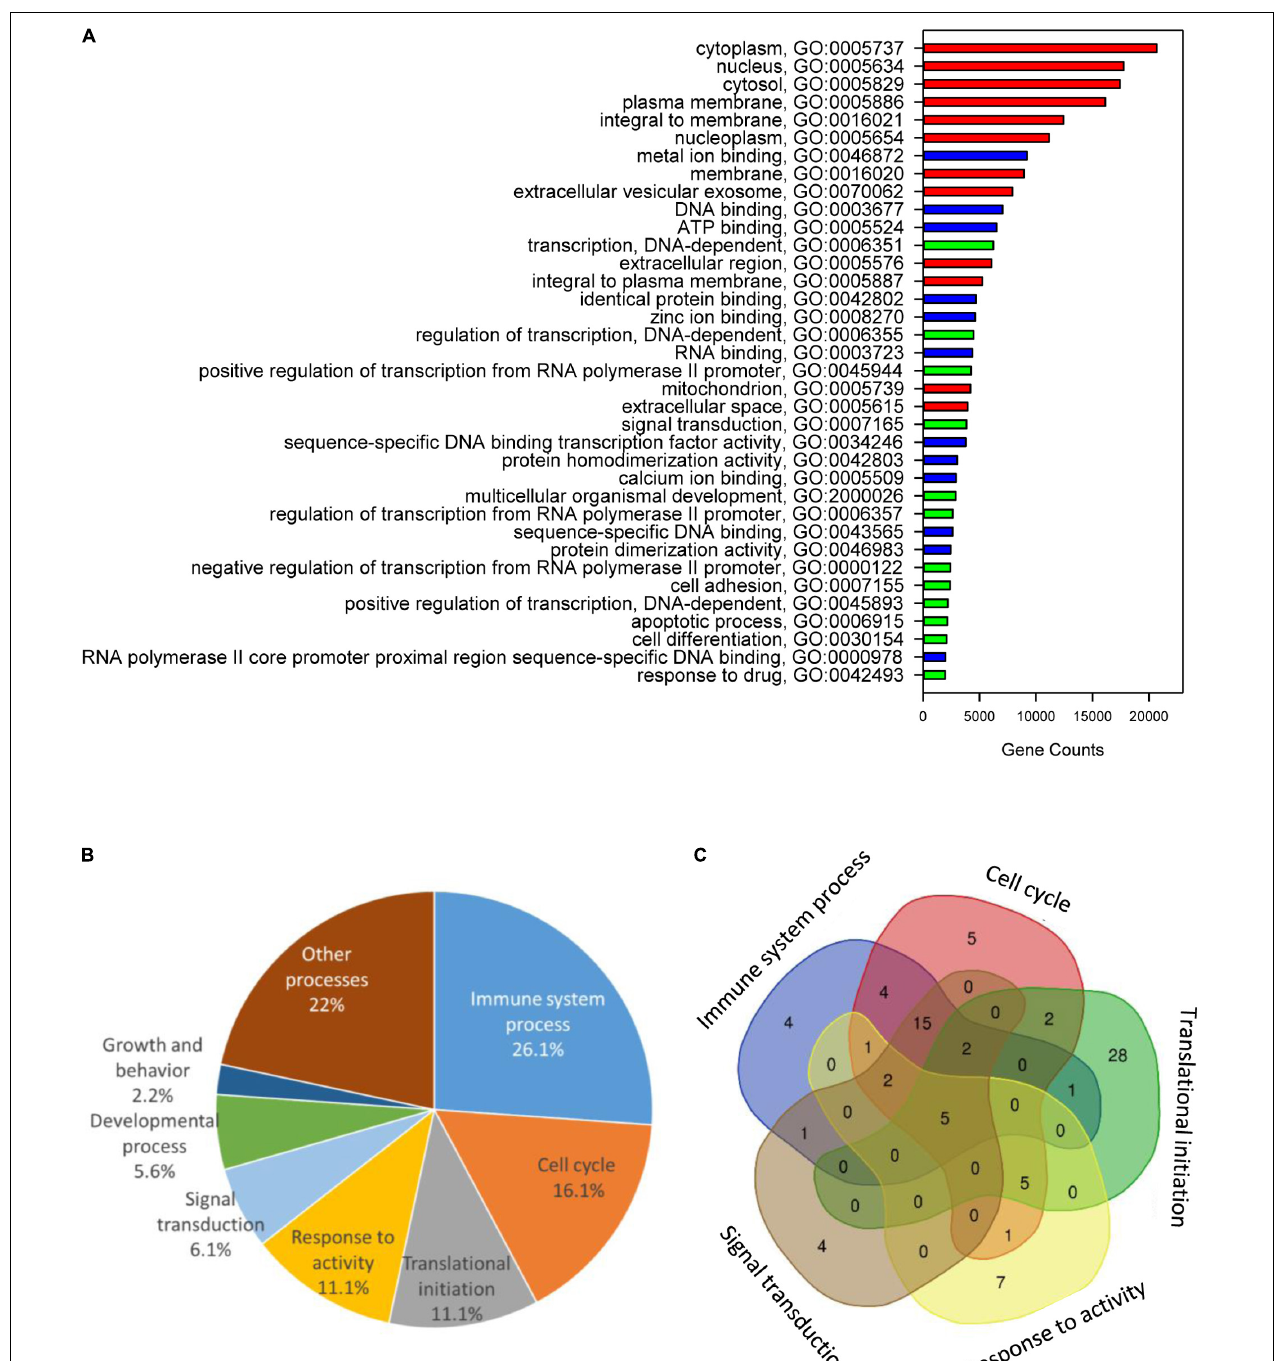
FIGURE 3 | Chimeric genes functional annotation and gene ontology enrichment. (A) Gene Ontology (GO) functional annotation analysis over the whole gene model, showing the major GO biological processes (red), GO molecular functions (blue), and GO cellular components (green) for genes found in the gilthead sea bream genome. (B) Pie diagram representing the percentage of biological process-enriched GO term functional categories. (C) Venn diagram representing the overlapping of the unique gene descriptions between main functional categories.